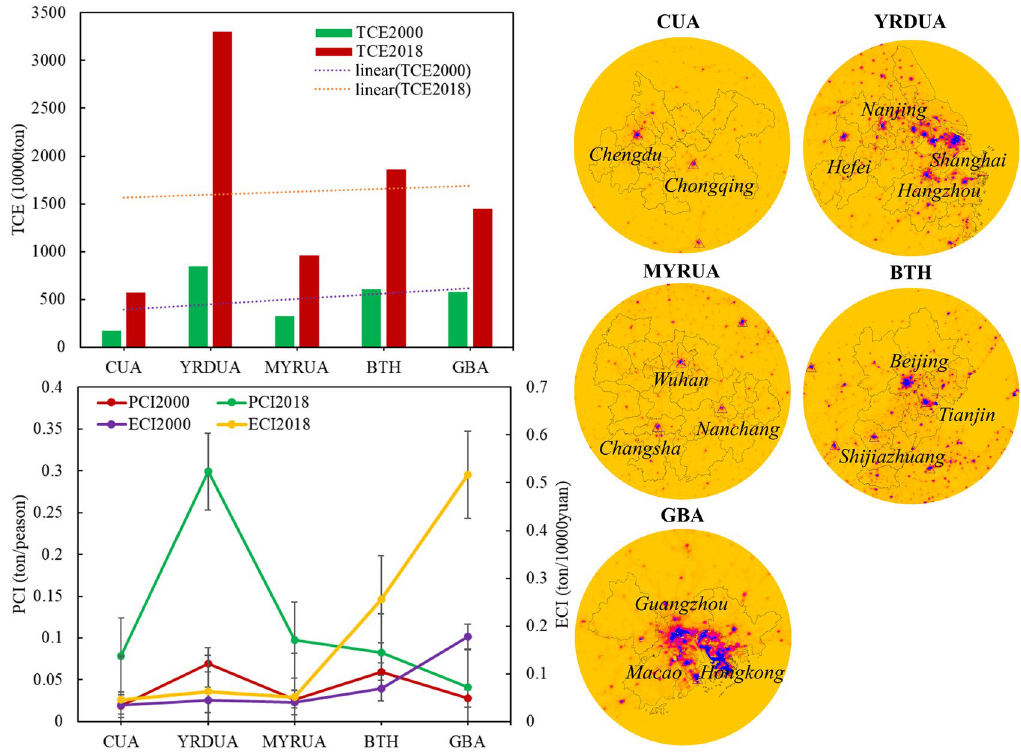
Figure 4. Comparison of TCE, PCI and ECI of the five national strategic urban agglomerations in China, 2000–2018.